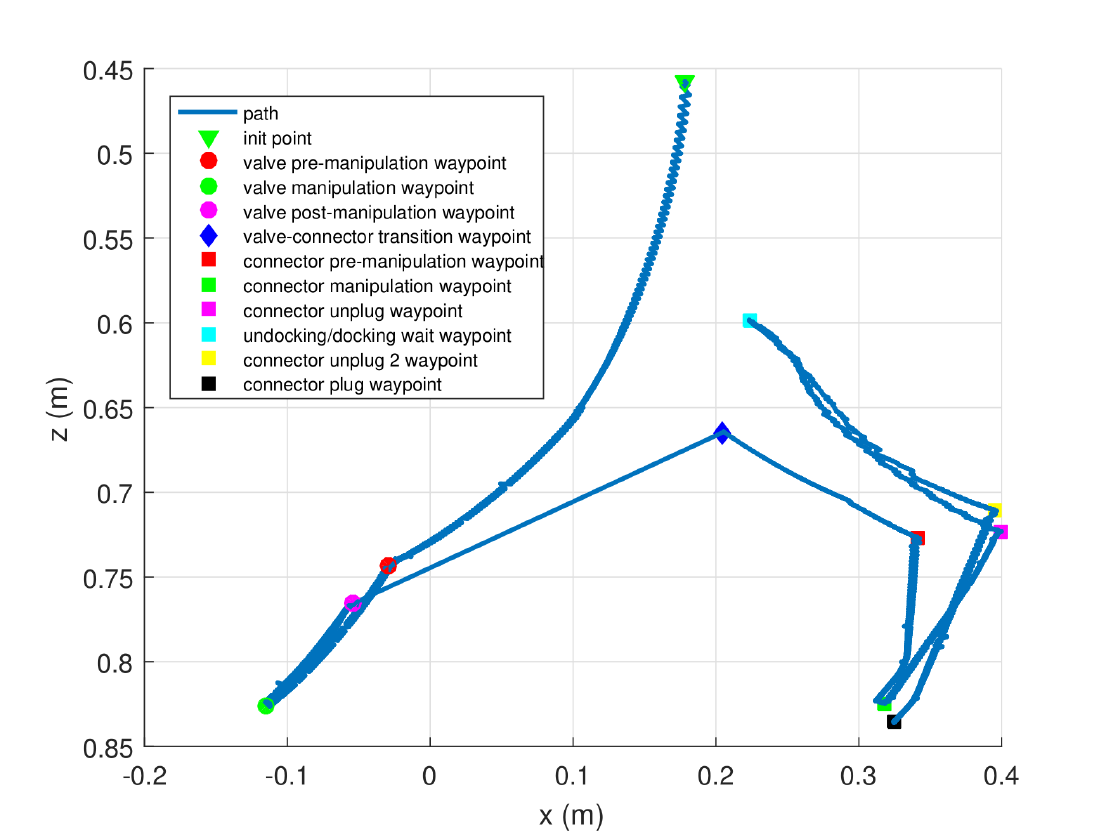
Figure 10. End-effector Cartesian trajectory with respect to the base of the arm during the intervention.